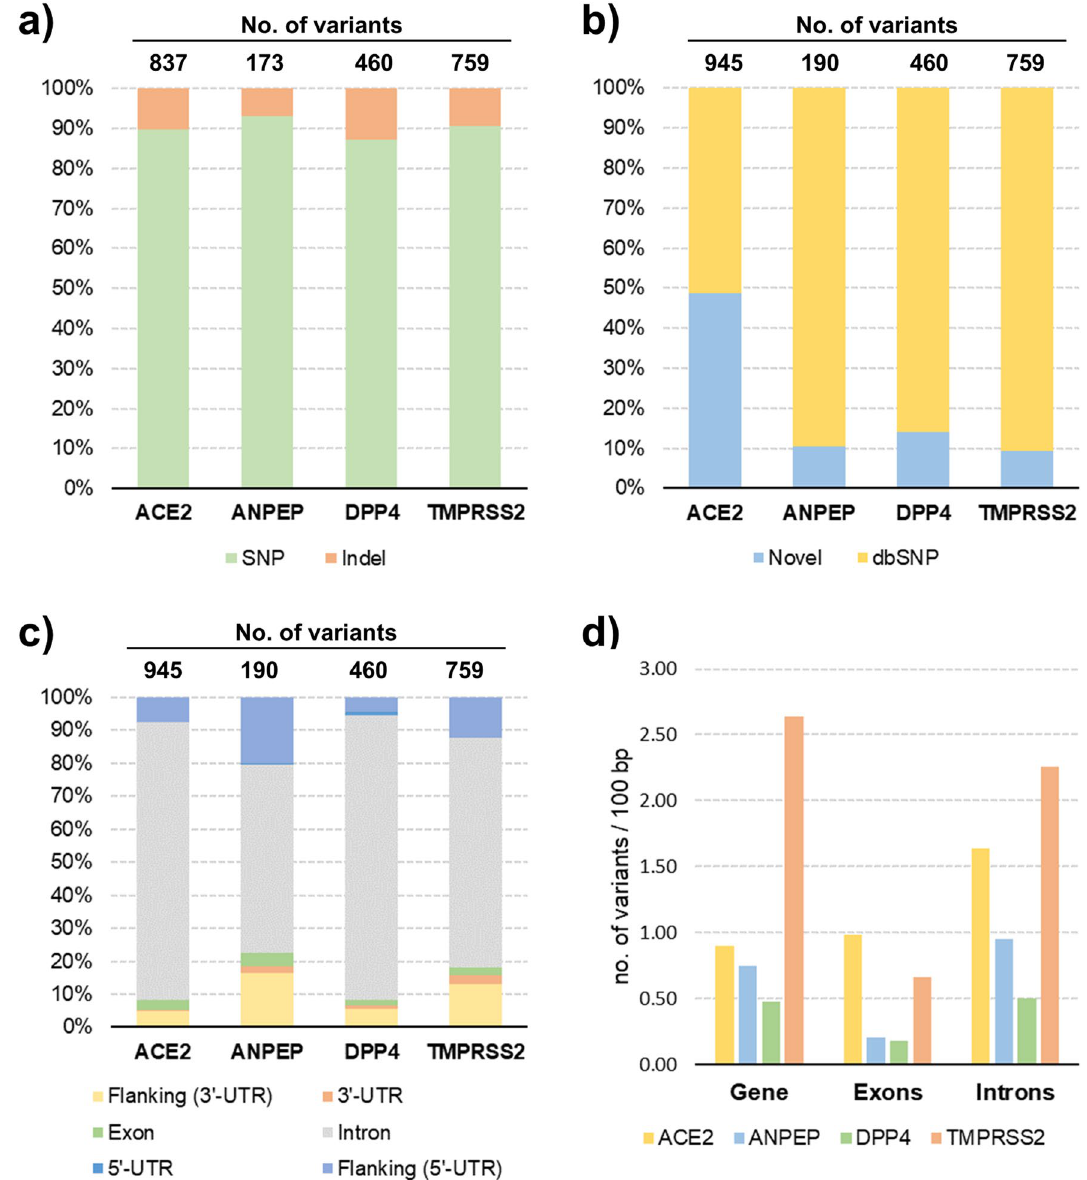
Figure 1. Variants in candidate genes discovered in the analysis of European pig breeds and wild boars. ( a ) Number of called single nucleotide polymorphisms (SNP) and insertions/deletions (indel); ( b ) Classification of variants as novel or already known (deposited in dbSNP); ( c ) Variant location at the gene level (untranslated region: UTR); ( d ) Expected distance of discovered variants stratified by gene feature. Gene length includes UTRs and flanking regions of 5 kbp upstream [flanking (5 ′ -UTR)] and downstream [flanking (3 ′ -UTR)]. Variant counts can differ since variants can co-locate or have multiple consequences as predicted with VEP tool. Details are given in Supplementary Table